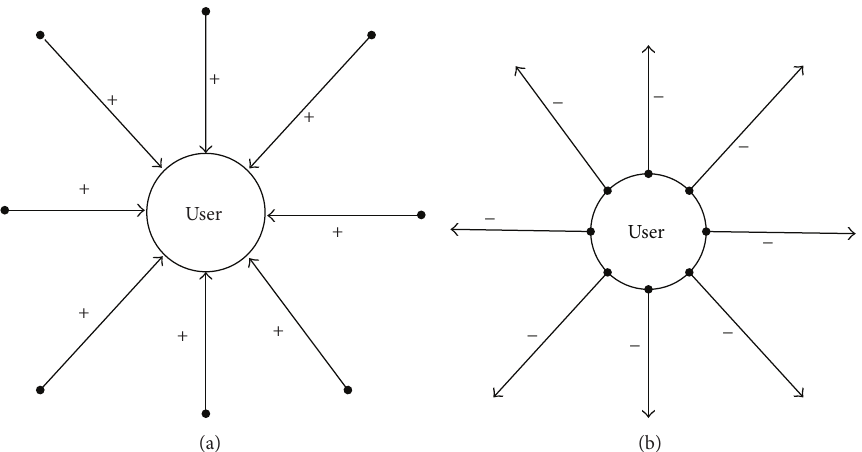
Figure 1: (a) The microblogger is followed or commented on by others; (b) the microblogger posts microblogs or comments on other users’ microblogs.